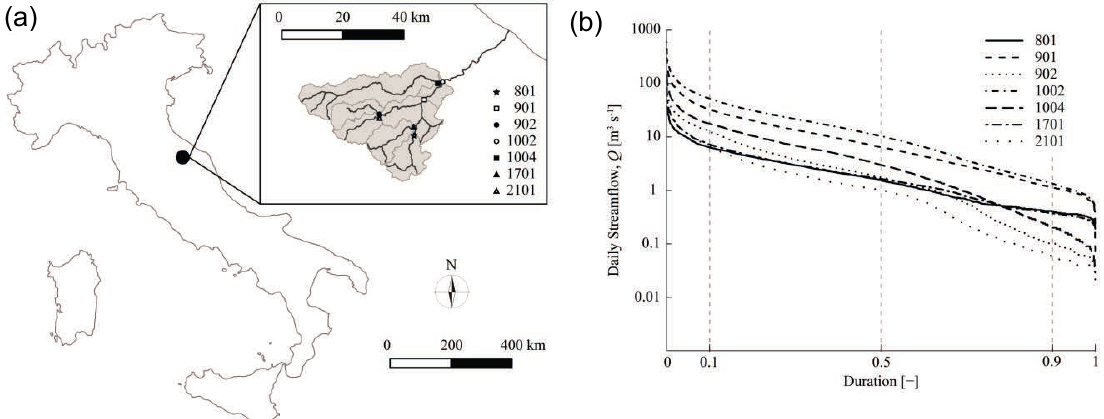
Fig. 1 (a) Study area: Metauro River closed at Barco di Bellaguardia (ID = 1002). (b) Flow-duration curves from measured daily discharge temporal sequences corresponding to the seven gauging stations along the Metauro River. Grey dashed vertical lines identify the 0.1-, 0.5-, 0.9-empirical